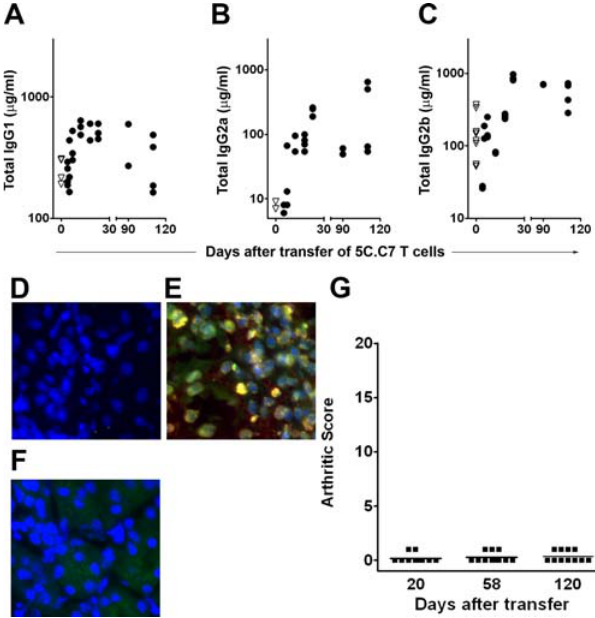
Figure 6. Autoantibodies and Arthritis Do Not Develop in the Presence of Polyclonal Endogenous T Cells (A–C) 3 million Ly5.1 þ ,5C.C7 T cells were transferred into mPCC þ / þ (T cell– replete) mice that had an intact repertoire of polyclonal T cells. Serum antibody titers were measured at various days after transfer. Total IgG1 (A), IgG2a (B), and IgG2b (C) levels are shown (filled circles). Inverted open triangles represent titers before T cell transfer. Data are pooled from two separate experiments with two to five mice per time point. Similar results were obtained in two other experiments. (D–F) Serum from T cell–replete (F) or T cell–deficient (E) PCC transgenic mice were used to stain tester B10.A,Rag2 (cid:1) / (cid:1) kidney sections at 1:100 dilution. Staining with control serum from a normal B10.A mouse is shown in (D). (G) Development of arthritis scored in the T-replete mPCC